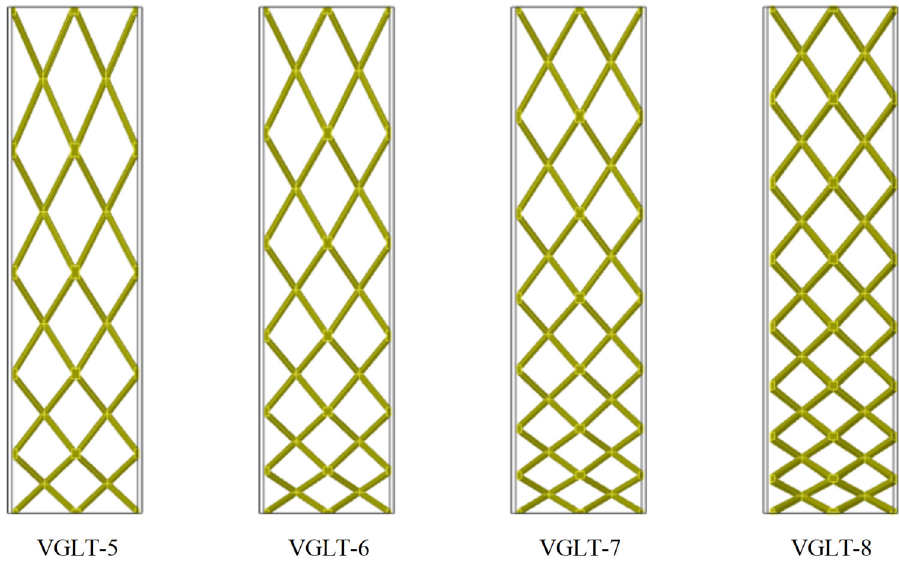
Figure 17. Lattice structure model inside the VGLT hybrid structure with different gradient config- urations.